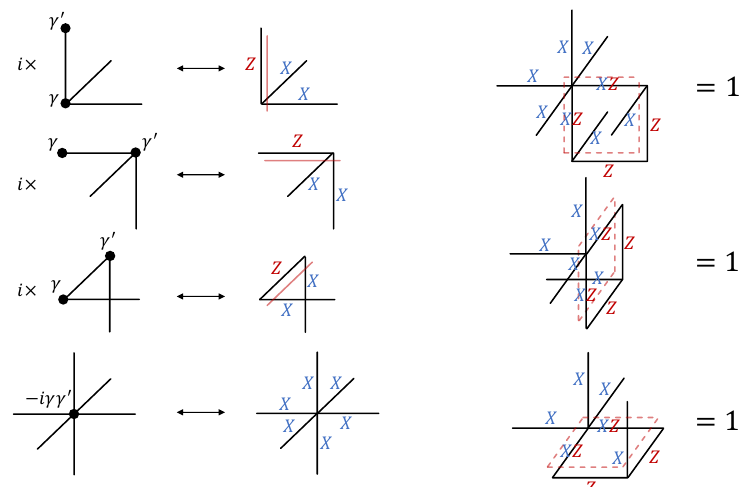
γ ′ along the i j dressed with other e